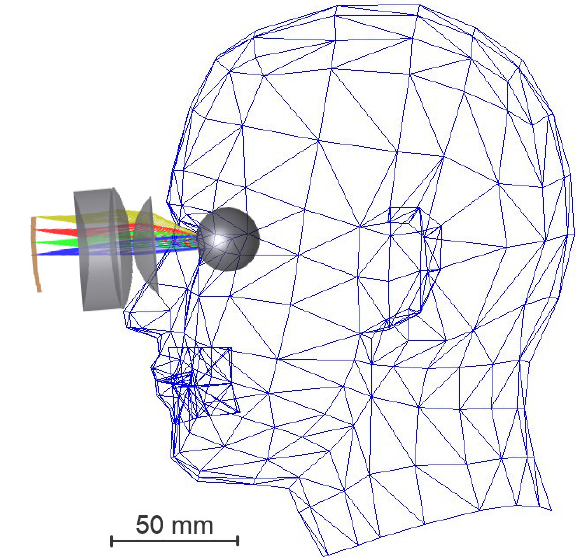
Figure 6. Model of the VR projection system setup on a human head.